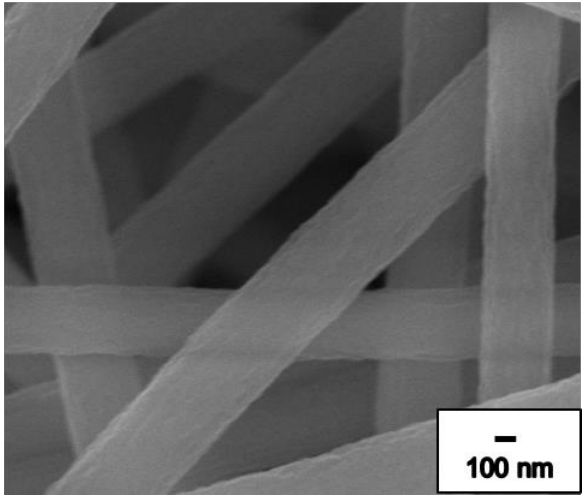
Figure 2. Field emission scanning electron microscope and energy dispersive spectrometer (FE-SEM) image of pure PAN ES NFs with 10,000× magnification.